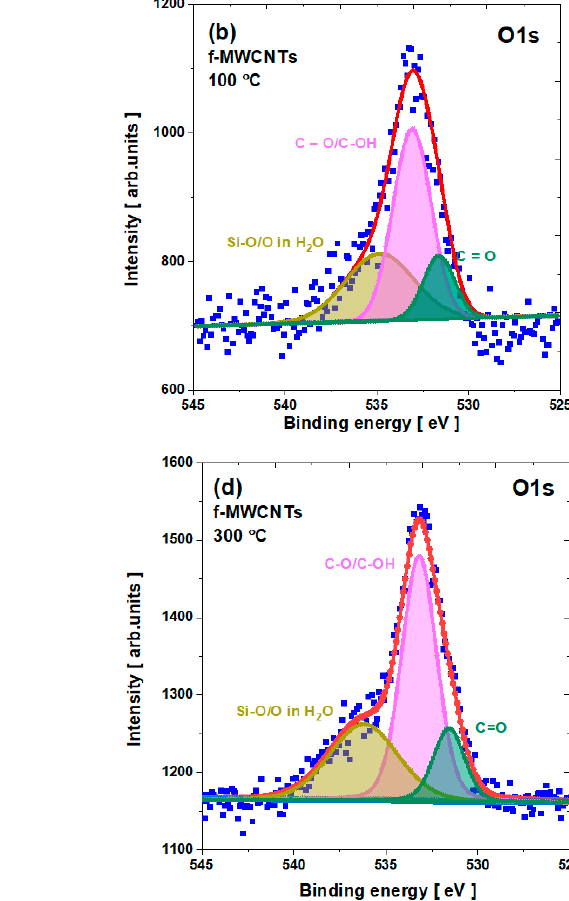
Figure 7. The O1s core level line for f-MWCNTs: ( a ) pristine; ( b ) calcined at 100 °C; ( c ) calcined at 200 °C; and ( d ) calcined at 300 °C.